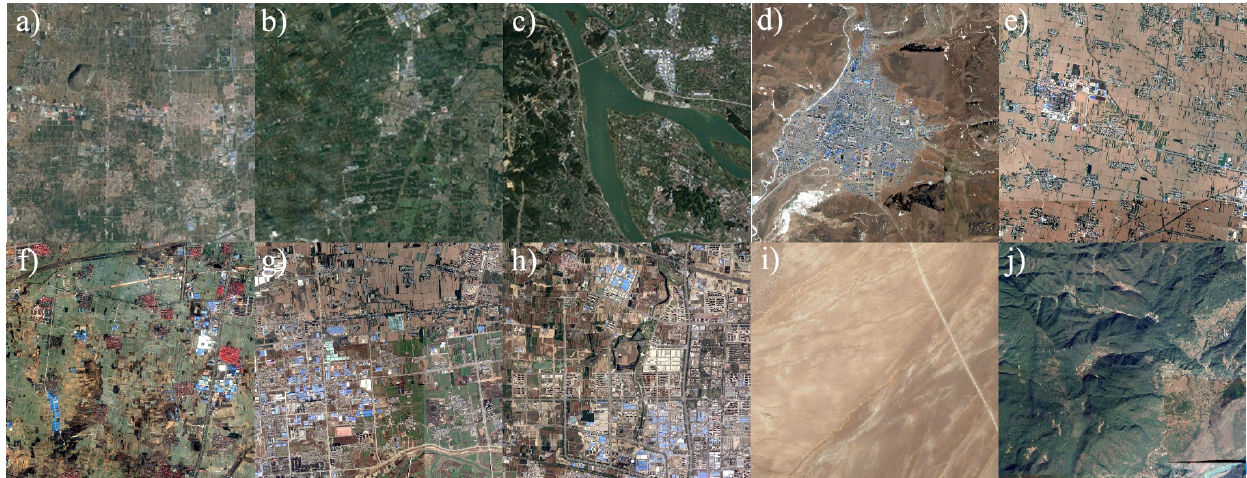
Figure 3. Selected locations for data training (a–c) and data validation (d–j) : (a) Baoding, (b) Shanghai, (c) GBA, and d) Nagqu, (e) Baoji,